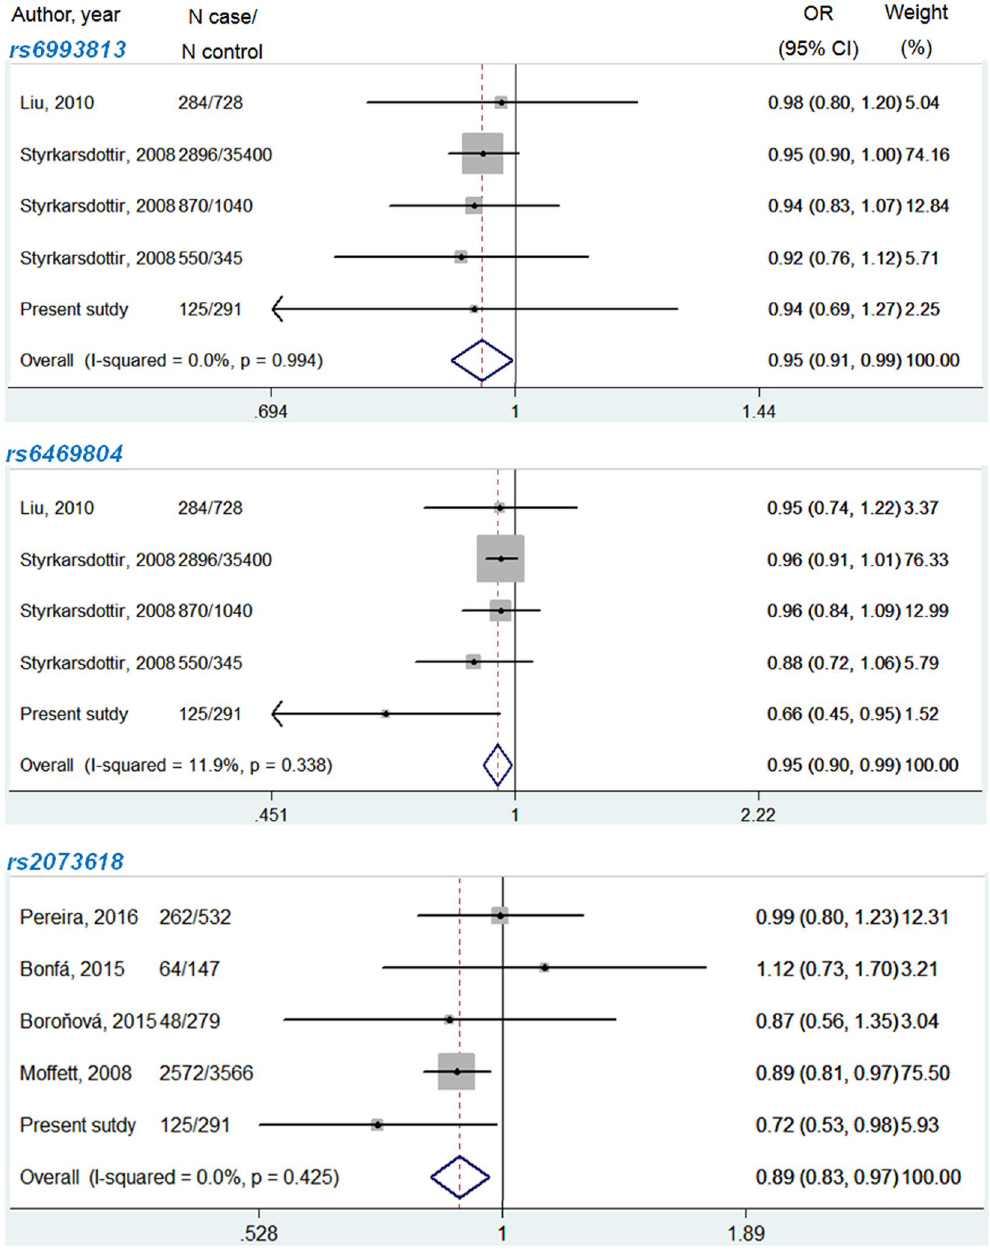
Figure 2. Forest plot of meta-analysis for rs6993813, rs6469804 and rs2073618 of the OPG gene using fixed- effect